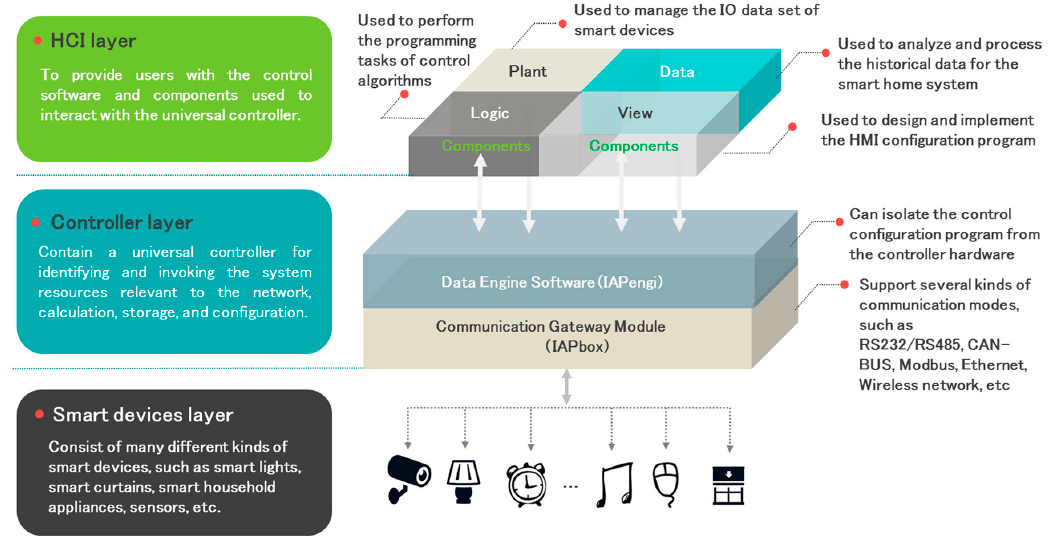
Figure 2. IAPhome software architecture and principle.